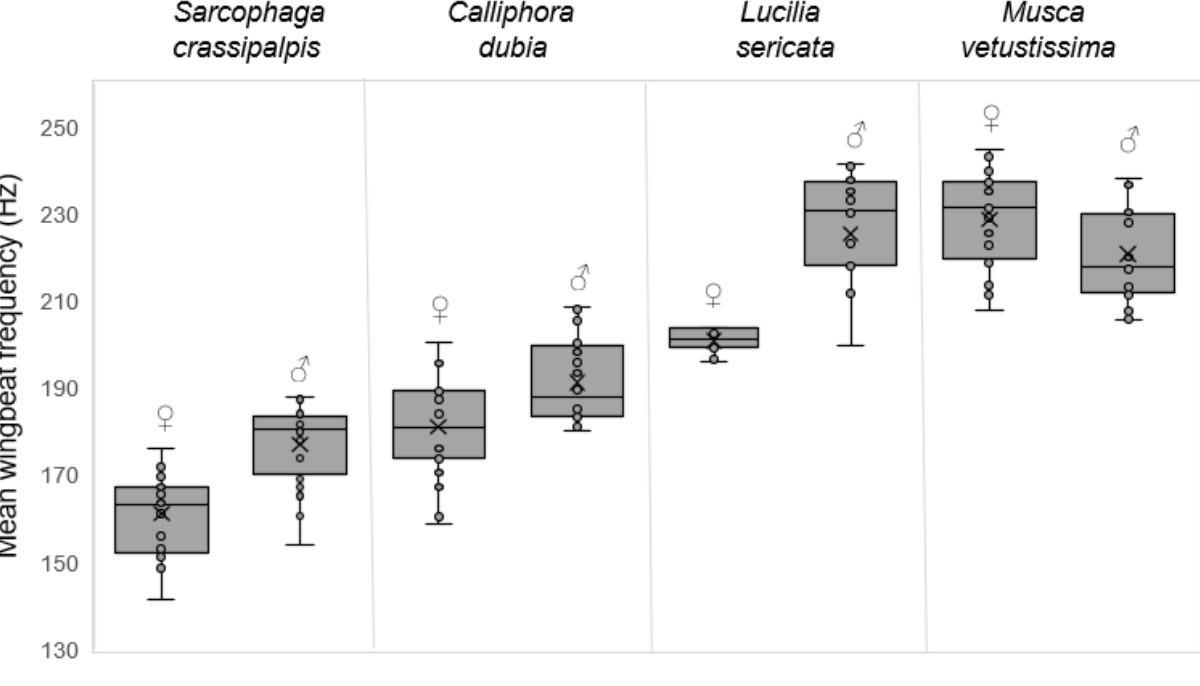
Figure 3. Mean wingbeat frequency of four recorded species separated by sex. Mean is denoted with ‘X’ and upper and lower quartiles have been calculated using an inclusive median.